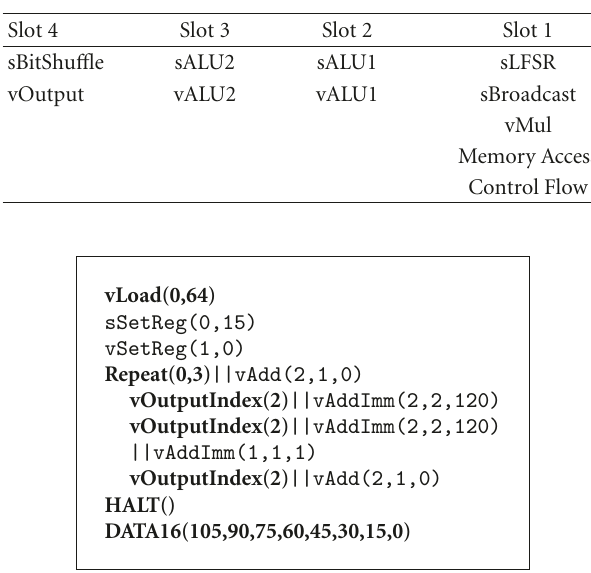
Table 7: VLIW instruction format.